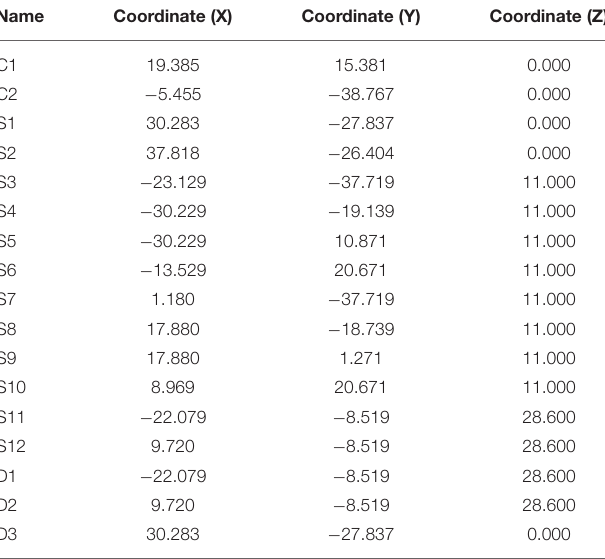
TABLE 3 | Information of the lifting tasks. TABLE 4 | Coordinates of the tower cranes and supply and demand